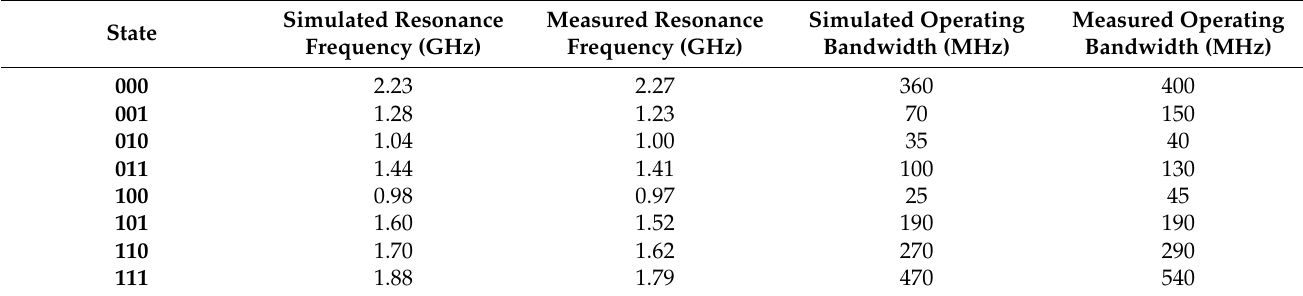
Figure 9. Measured reflection coefficient at different states ( a ) and photograph ( b ) of the fabricated 3-bit frequency reconfigurable MMA. Table 2. Simulated and measured resonance frequency and operating bandwidth for all the eight narrowband states.